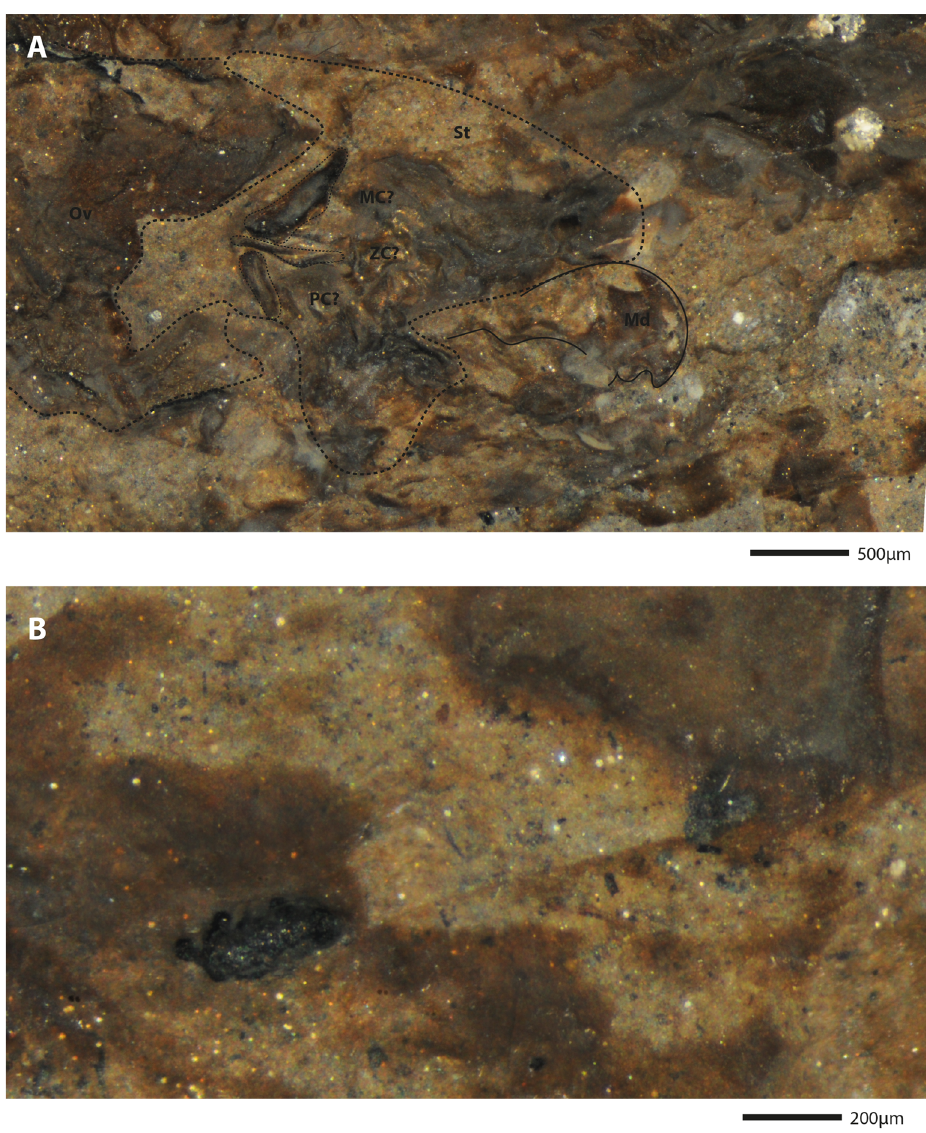
Figure 9. Zoomed photographs of the holotype Bechleja brevirostris n. sp. (SF-MeI 5933 B). ( A ) View of the stomach: St, stomach; Md, mandible; MC, mesocardiac ossicle; ZC, zygocardiac ossicle; PC, pterocardiac